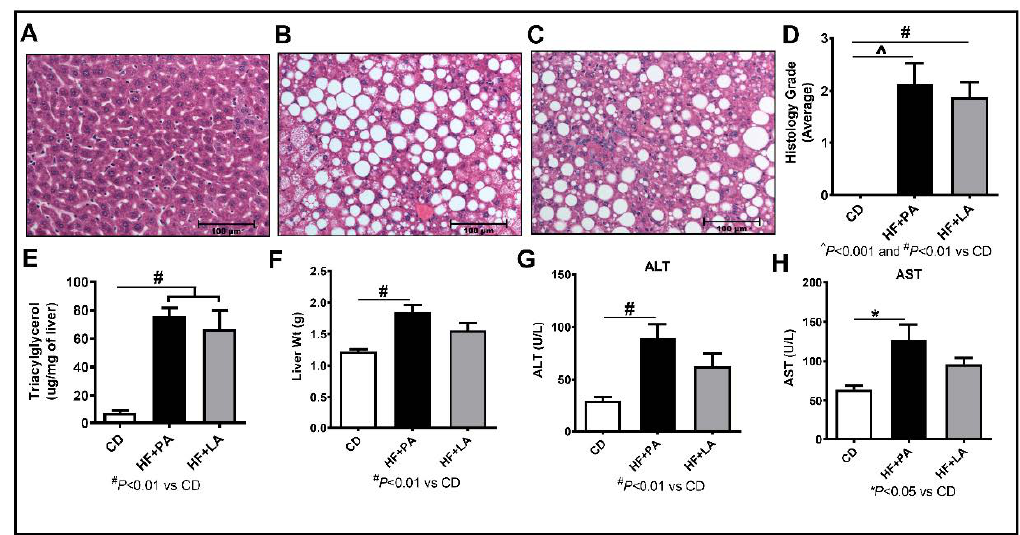
Figure 6. Effect of HF diet supplemented with PA or LA on markers of non-alcoholic fatty liver disease (NAFLD). Liver sections (4 μ m) from CD ( A ), HF + PA ( B ), and HF + LA-fed mice ( C ) were stained with hematoxylin and eosin. Pictures were taken at 20X magnification using a Nikon Eclipse 80i microscope. Histological grade for the degree of steatosis is shown ( D ). Quantification of liver triacylglycerol by gas chromatography ( E ). Liver weight measured at sacrifice is provided ( F ). Plasma levels of ALT and AST, markers of liver injury are shown ( G , H ). Values are expressed as mean ± SEM of 6–8 samples in each group. * p < 0.05, # p < 0.01, and ^ p < 0.001 versus CD. ALT, alanine aminotransferase; AST, aspartate aminotransferase; CD, chow diet; HF + PA, high fat + palmitic acid; HF + LA, high fat + lauric acid.